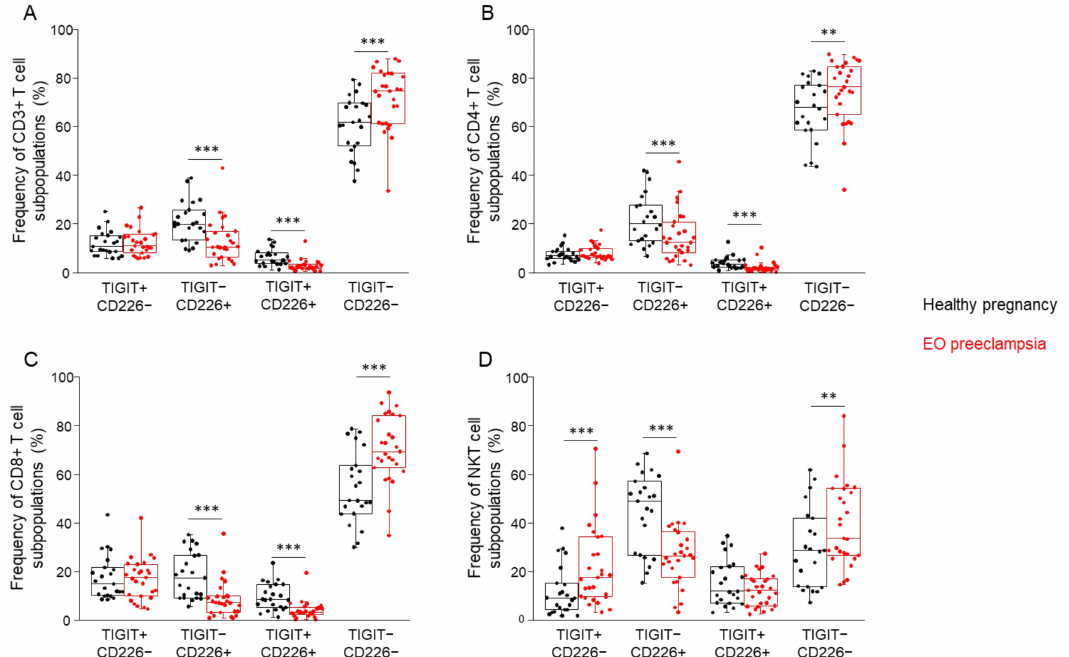
Figure 4. The frequency of the investigated T cell subpopulations is based on the presence or absence of TIGIT and CD226 receptors in women with EO preeclampsia and healthy pregnant women. The frequency of CD3+ T- ( A ), CD4+ T- ( B ), CD8+ T- ( C ), and NKT ( D ) cell subpopulations is based on the surface presence or absence of the TIGIT and CD226 receptors in women with EO preeclampsia and healthy pregnant women. The solid bars represent medians of 24 and 27 determinations, respectively, the boxes indicate the interquartile ranges, and the lines show the most extreme observations. Differences were considered statistically significant for p -values < 0.05 **, p < 0.01